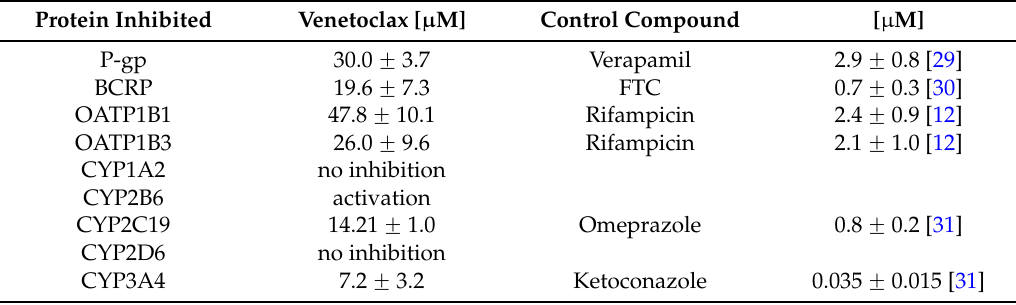
Table 1. IC 50 values for transporter and CYP inhibition by venetoclax.